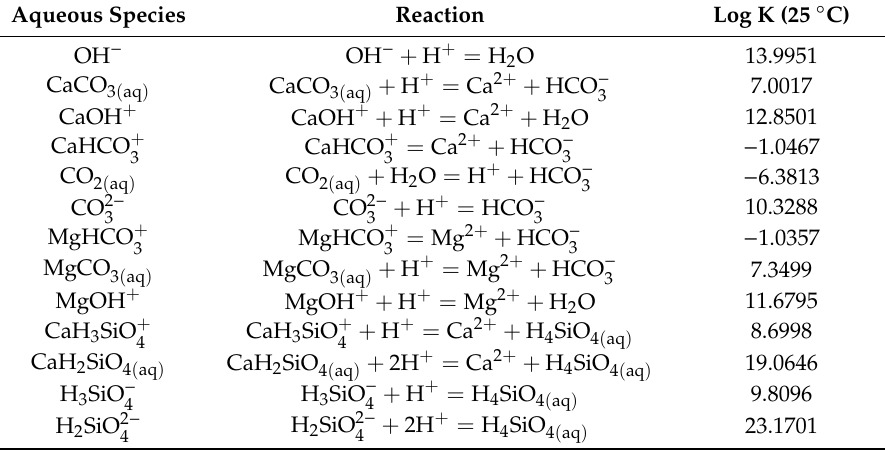
Table A2. Thermodynamic data for complex solute species. Basis species the model are H 2 O, H + , − Ca 2 + , HCO , H 4 SiO 4 ( aq ) and Mg 2 + . All thermodynamic data is taken from JAEA-TDB v1.07 [35]. 3